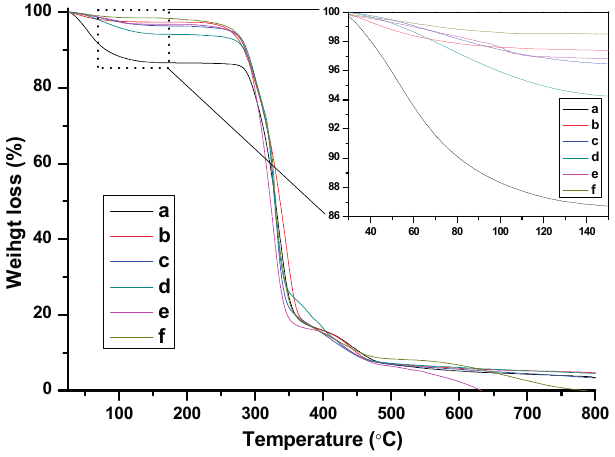
Figure 7. TG curves of BIm-based nanogels with different monomers and feed ratio. (( a ) [C 6 VIm]Br:EGDMA = 15:1; ( b ) [C 8 VIm]Br:EGDMA = 10:1; ( c ) [C 6 VIm]Br:EGDMA = 5:1; ( d ) [C 6 VIm]Br:EGDMA = 10:1; ( e ) [C 12 VIm]Br:DVB = 10:1; ( f ) [C 6 VIm]Br:DVB =